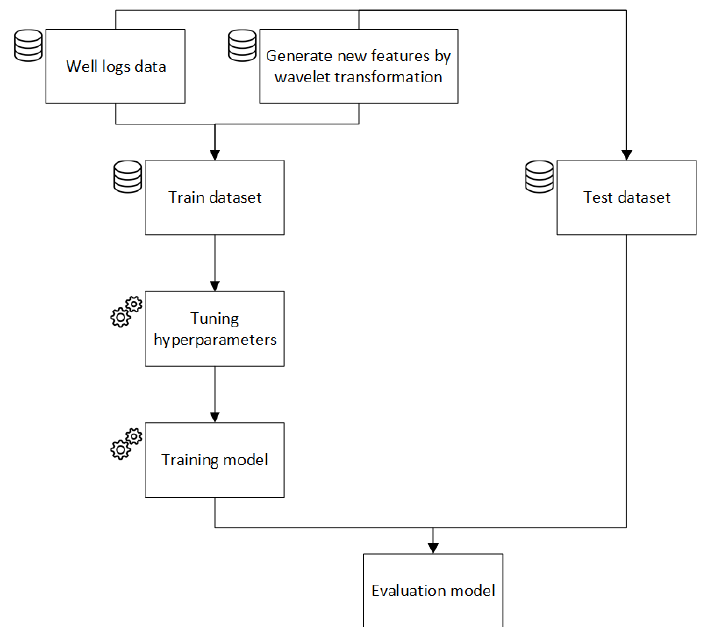
Figure 2. Flowchart of workflow for machine learning